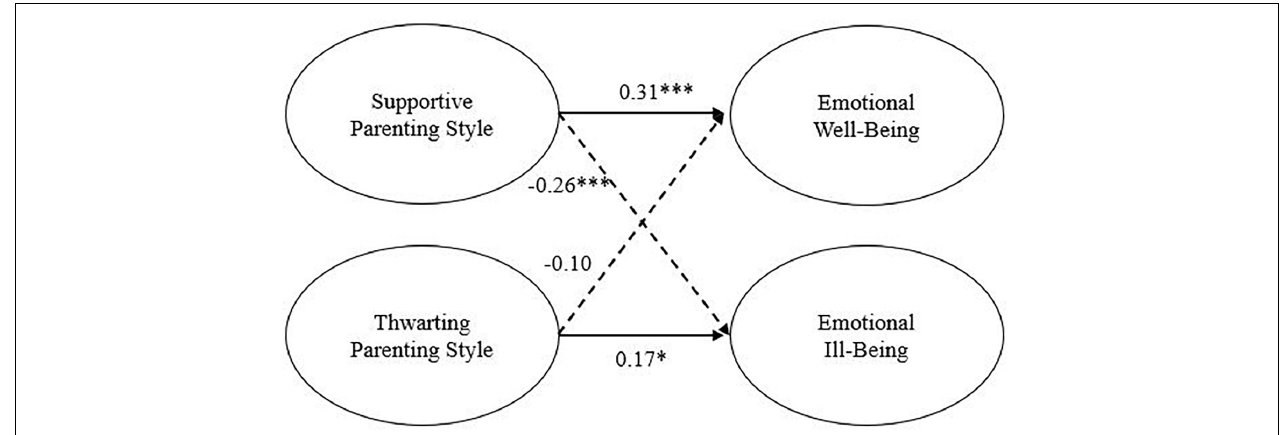
FIGURE 2 | Standardized structural equation of Model 1. Solid lines indicated positive relations, and dashed lines indicated negative relations. * p < 0.05, ** p < 0.01, *** p <